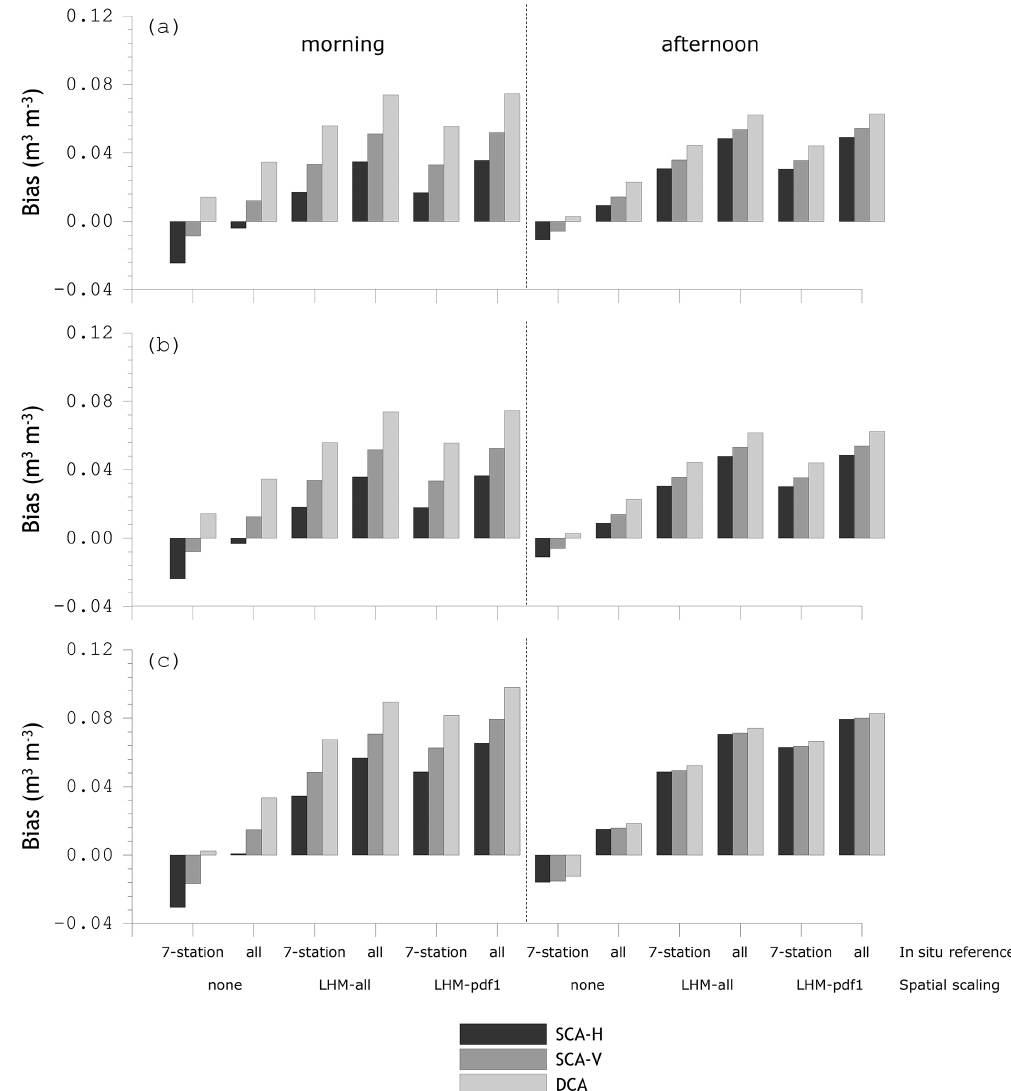
Figure 10. Bias computed between SMAP soil moisture retrieved and in situ references; (a) the metrics for reference pixel 3306, (b) for reference pixel 3606, and (c) for reference pixel